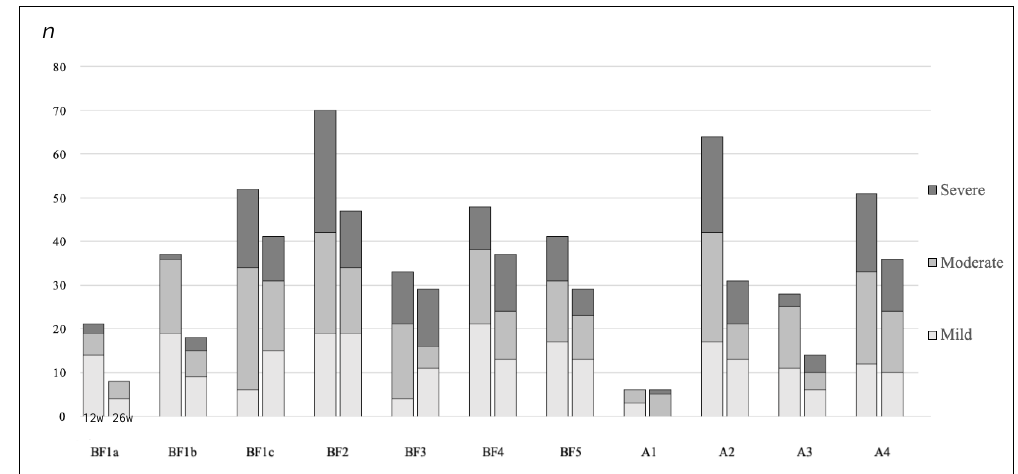
Figure 2. Changes of PCS severity phenotypes (mild, moderate, severe). Legend: BF1 = Breathlessness: (a) at rest, (b) dressing, (c) stairs; BF2 = Fatigue; BF3 = Pain/discomfort; BF4 = Anxiety; BF5 = Depression; A1 = Communication; A2 = Mobility; A3 = Personal Care; A4 = Usual Activities.